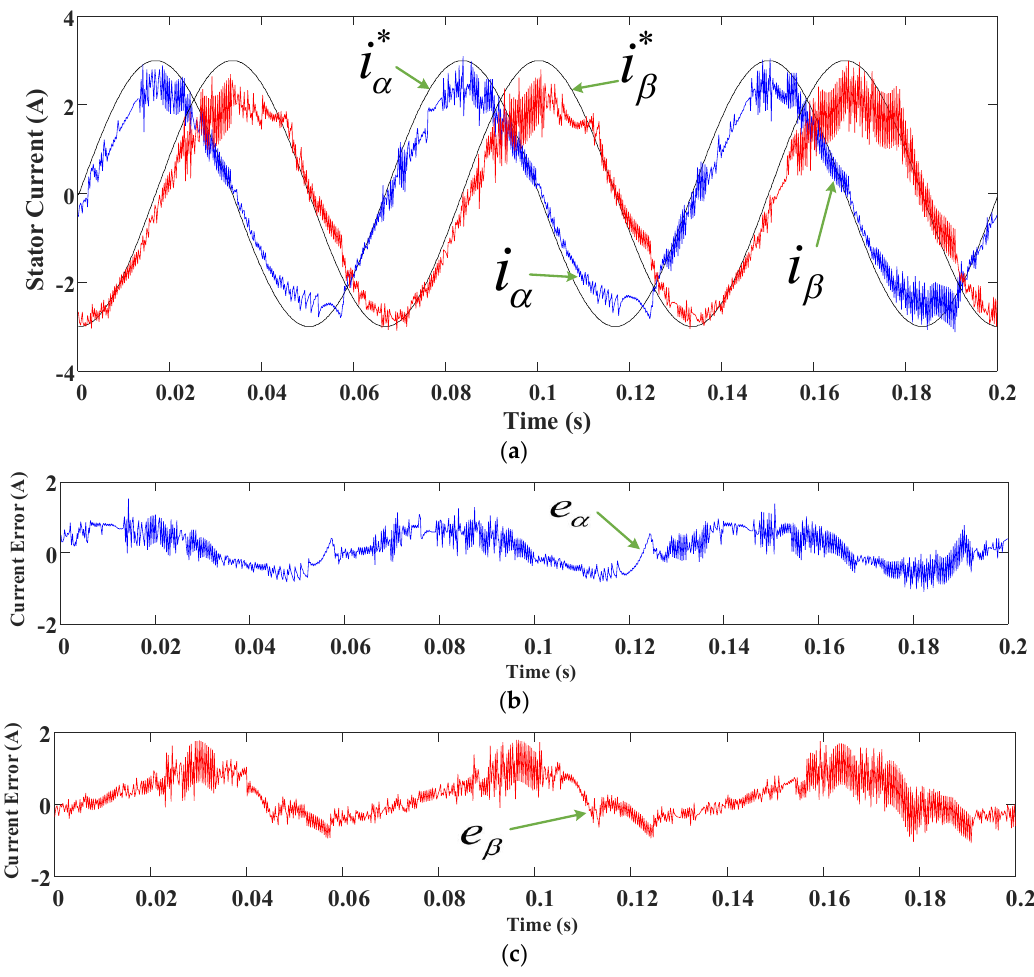
Figure 12. Experimental results of SVV-MPCC following a sinusoidal current command with amplitude 3 A and frequency 30 Hz (case 2): ( a ) current responses; ( b ) α -axis current error; ( c ) β -axis current error.